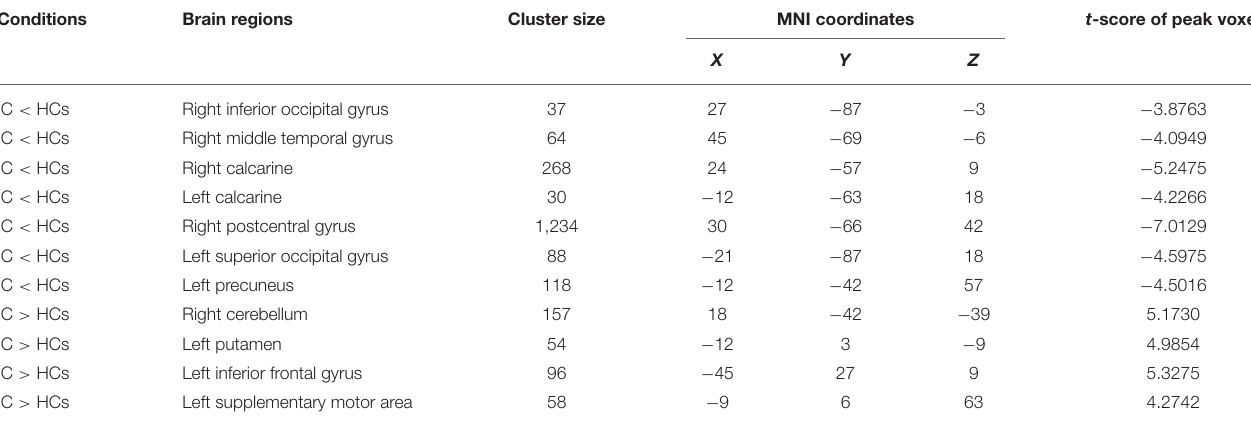
TABLE 2 | Brain regions with significantly different ReHo signal values between the iridocyclitis patients and healthy volunteers. Conditions